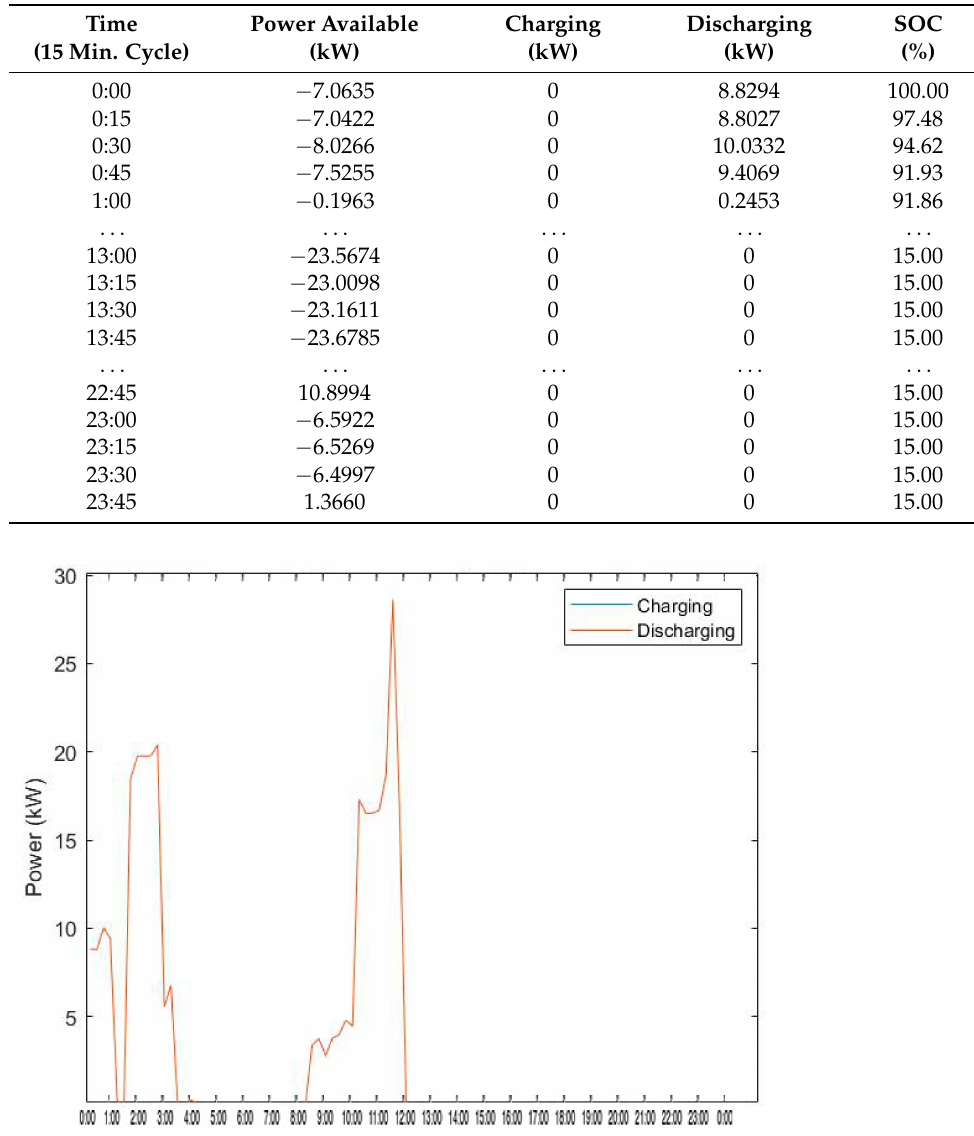
Table 12. Power available, Charging, Discharging and SOC values in CSPVCD.